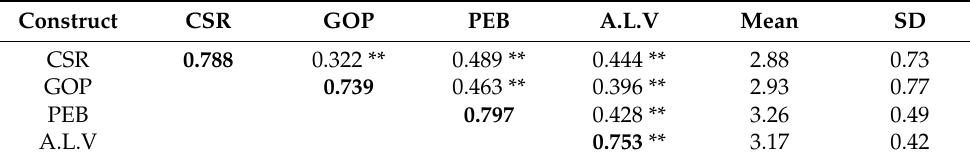
Table 3. Correlations and discriminant validity.